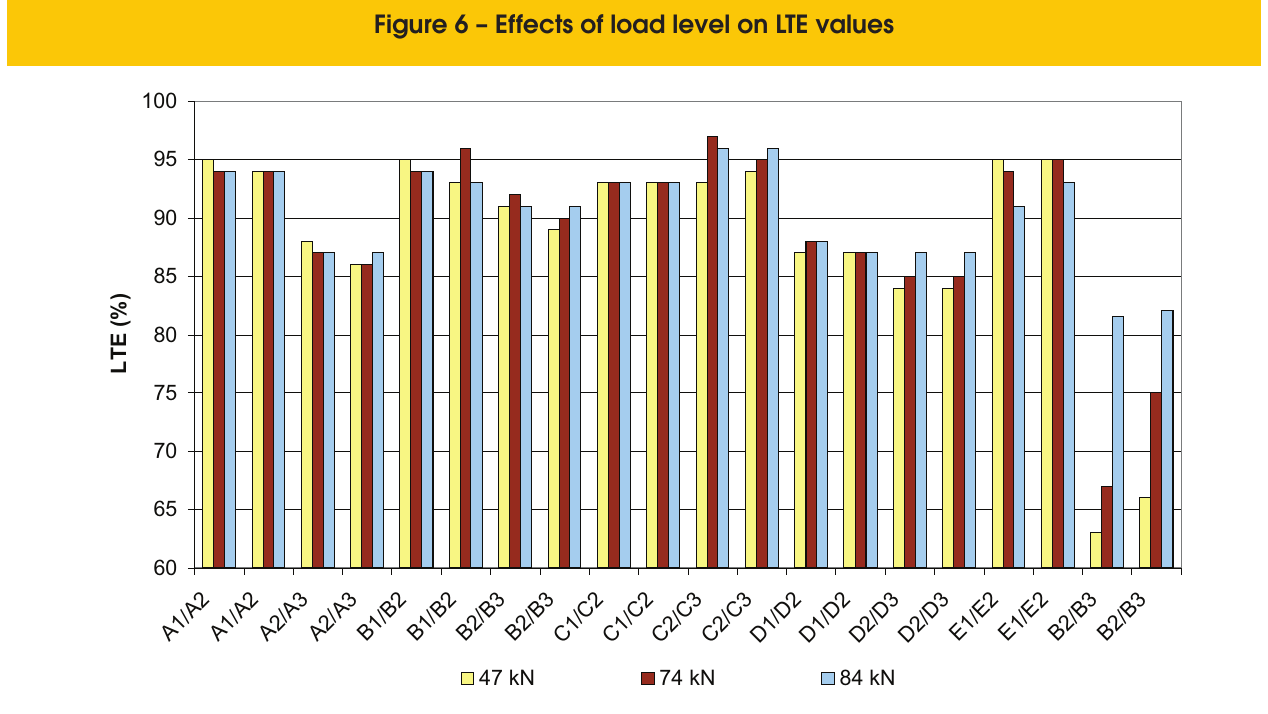
Figure 6 – Effects of load level on LTE